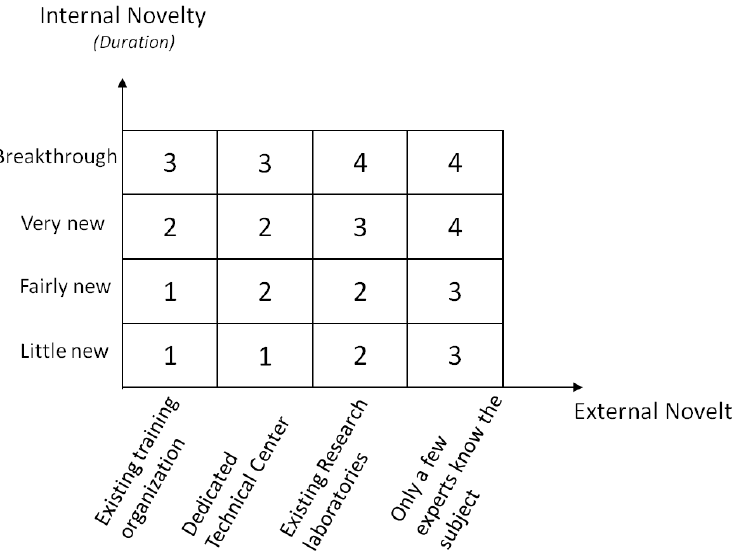
Figure 3. Project characterization matrix according to its novelty degree.